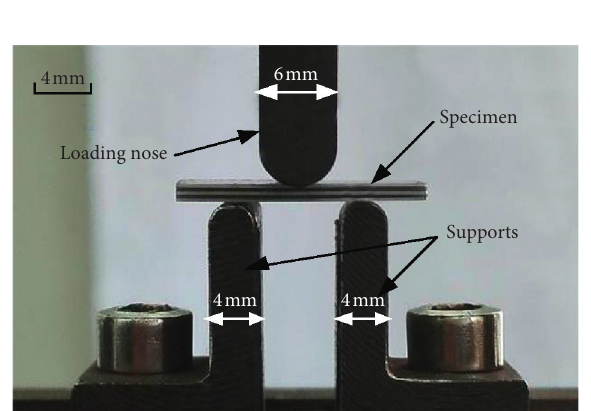
Figure 7: Short-beam method shear experiment